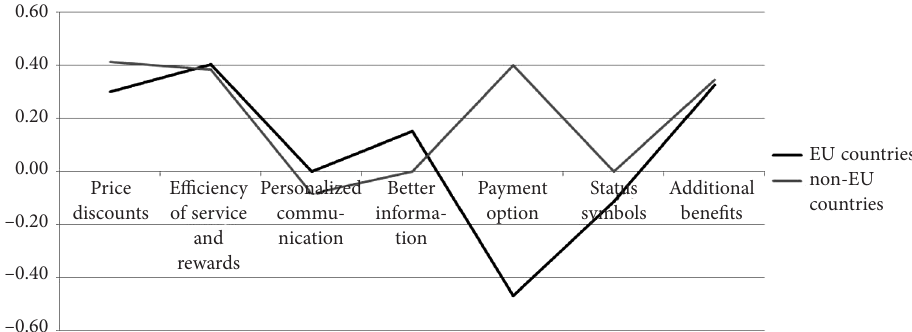
Figure 1. Differences in the expected benefit of consumers in terms of analysed indicators in groups of EU/non-EU